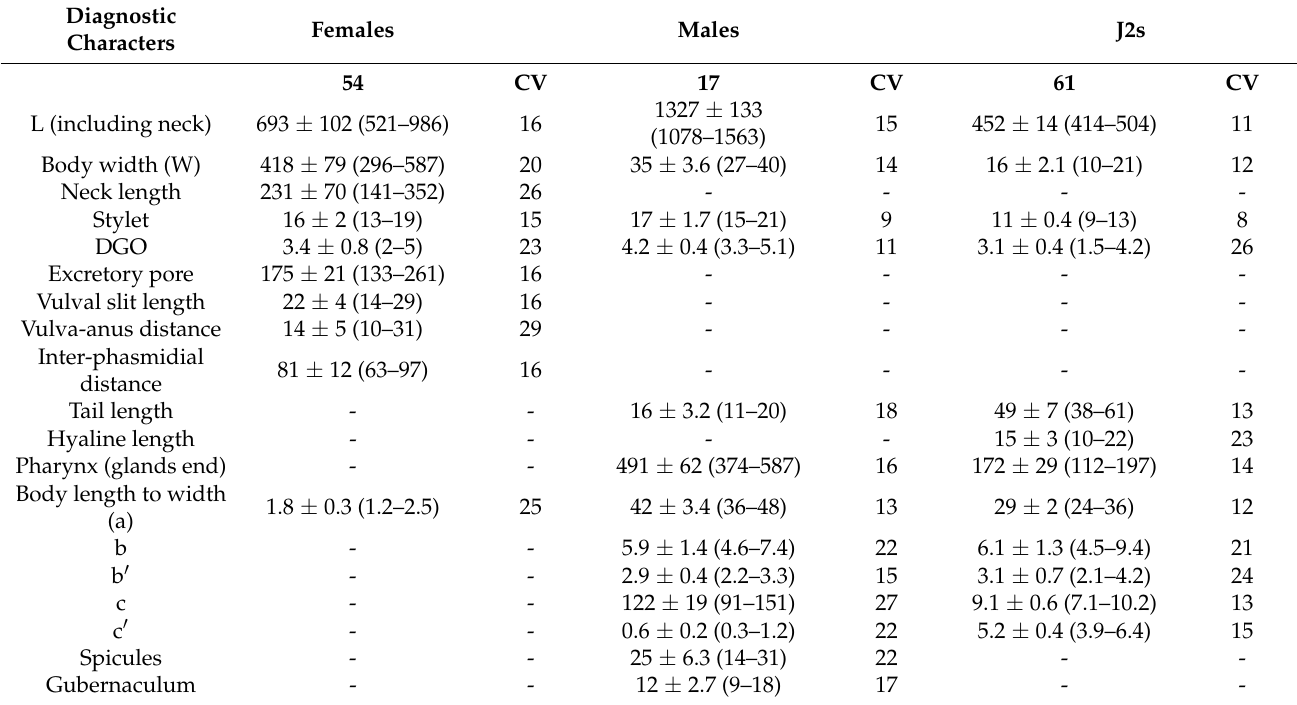
Table 3. Average of the morphometrics of females, second-stage juveniles (J2s) and males of the populations of Meloidogyne javanica studied in this research (Measurements are in µ m).